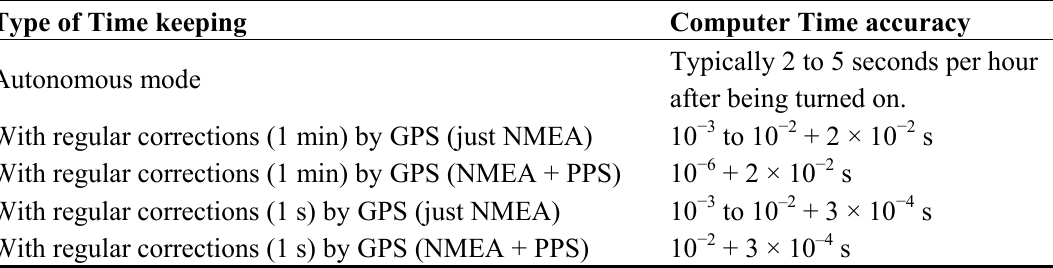
Table 2. Computer time